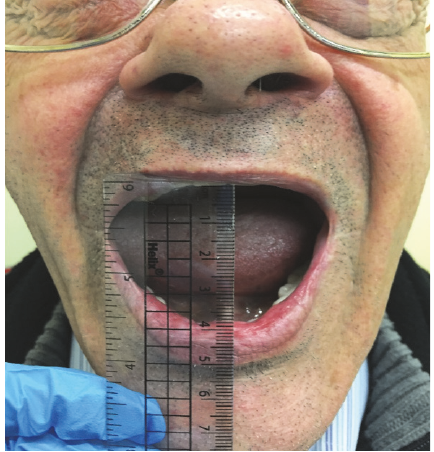
Figure 2: MIO of 38 mm at 3 months’